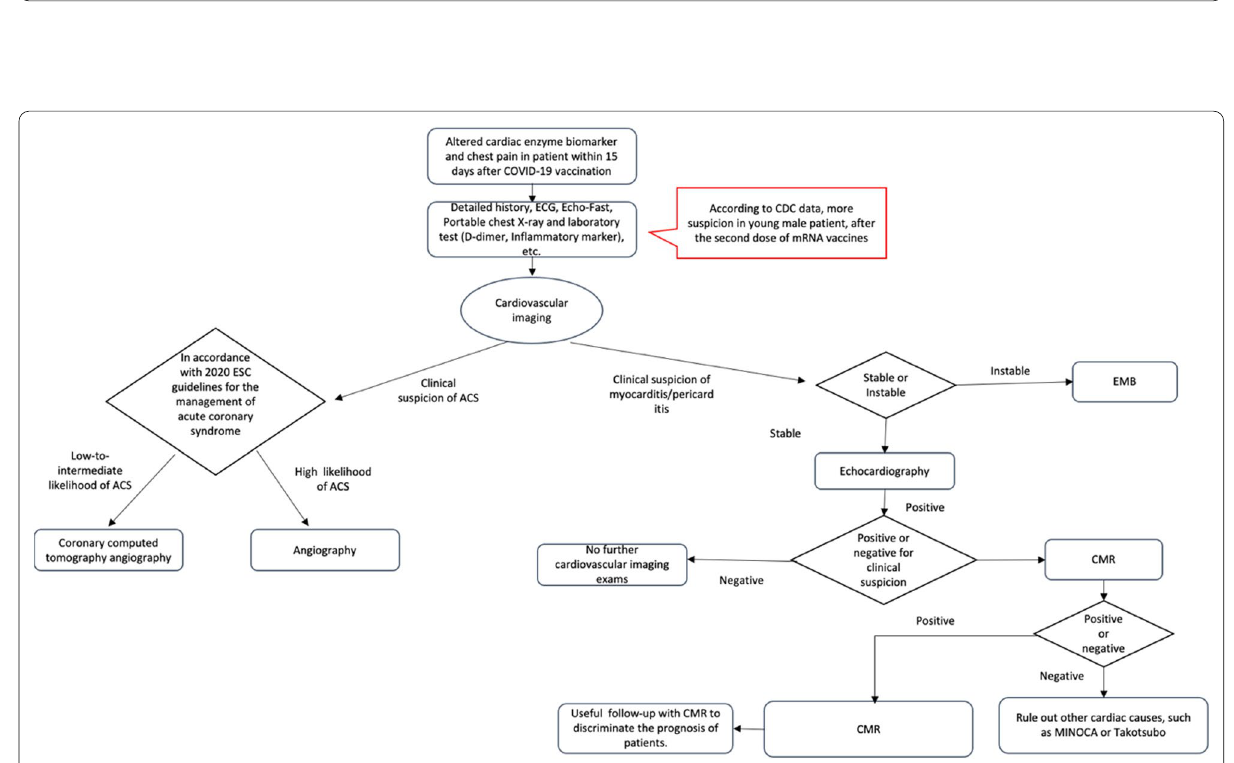
Fig. 3 Myocarditis after COVID-19 vaccination. T2-short tau inversion recovery CMR short axis ( a ), three-chamber ( b ) and four-chamber view revealing edema in the infero-lateral basal segment. T2 mapping short-axis view and T2 mapping in AHA 16-segment model ( d – g ) showed altered values in all myocardial segments, especially in the infero-lateral basal segments. T1 mapping ( i , j ) and ECV ( k , l ) short-axis view confirming the altered values. Late gadolinium enhancement three chamber ( m ) and short-axis ( n ) view demonstrating an intramyocardial infero-lateral scar